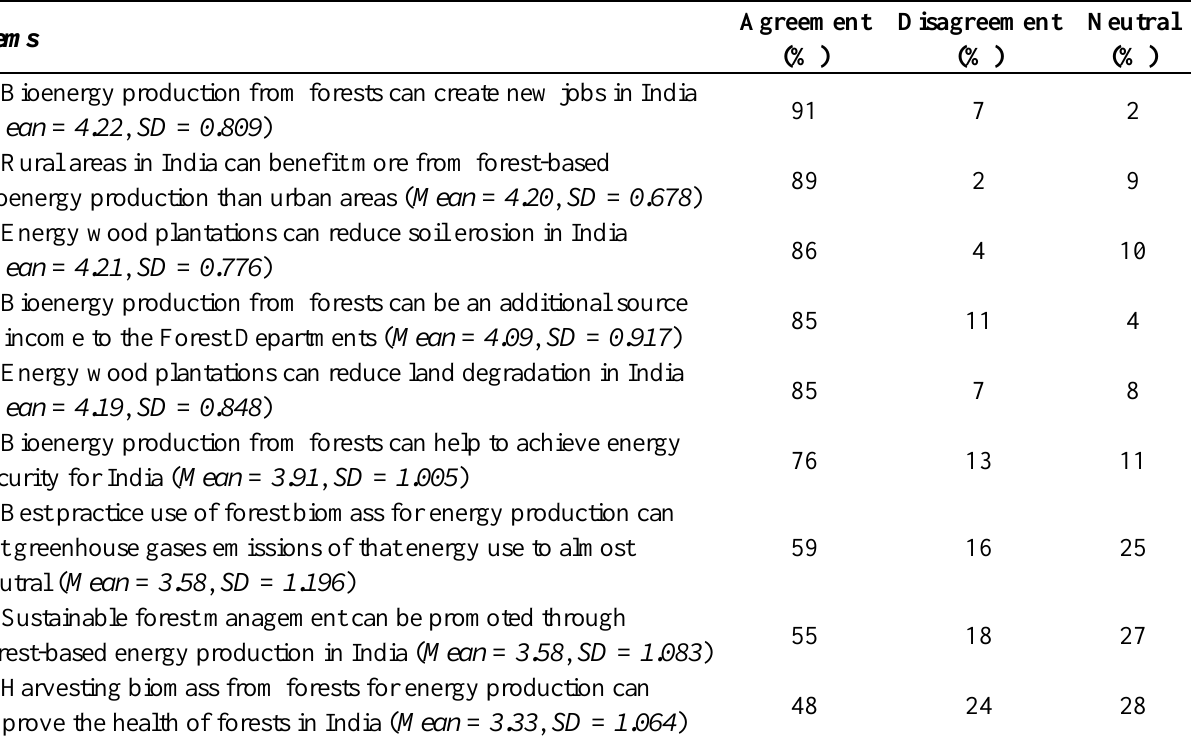
Table 3. Respondents’ perceptions of the potential benefits from forest-based bioenergy (FBE) projects in India ( N =